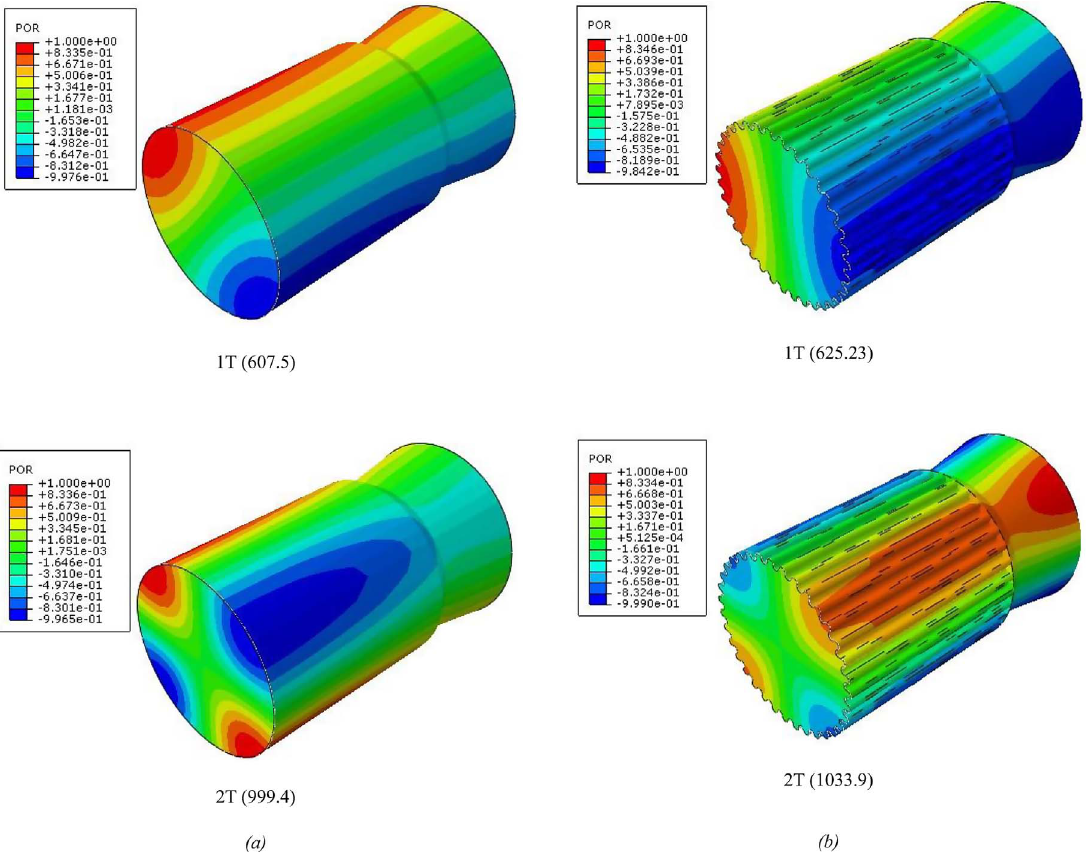
Figure 4. Pressure contours in the fi rst and second tangential modes: (a) unbaf fl ed and (b) baf fl ed (the cross-section is parallel to the free end and at a distance of half the total height from the